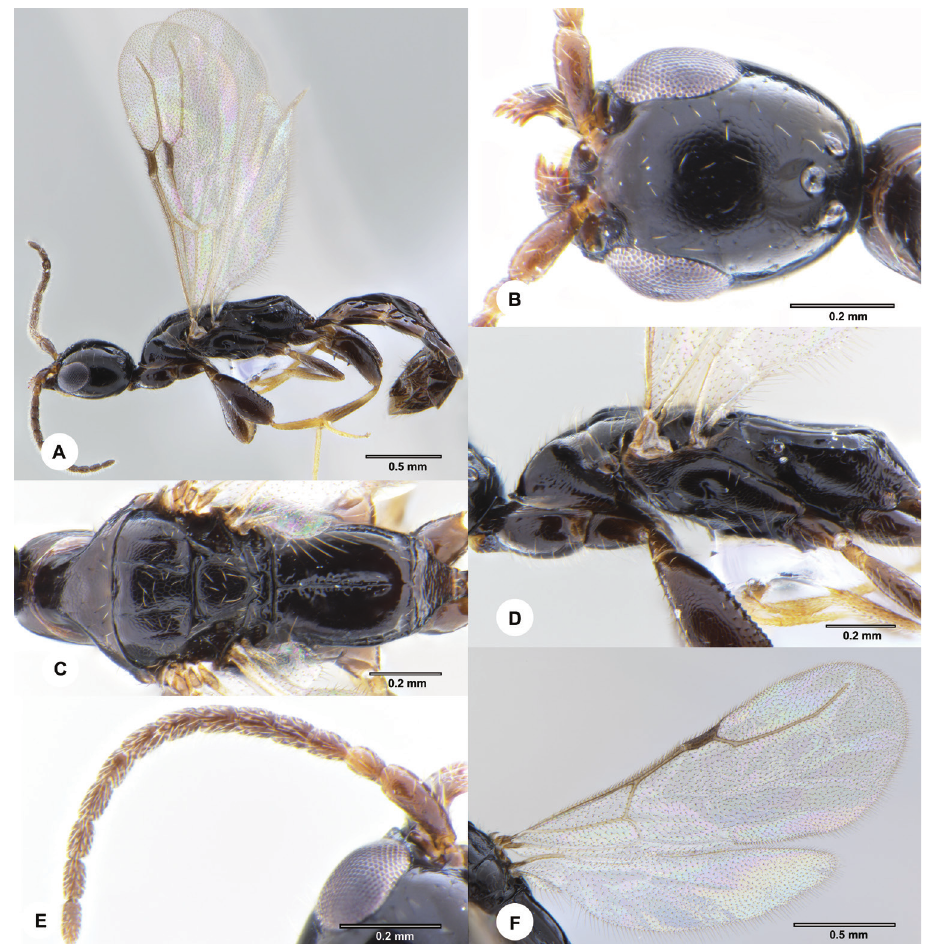
Figure 6. Foenobethylus yunkaishanensis Chen & Luo, sp. nov., male, holotype (SCAU 3048315) A lateral habitus B head, dorsal view C mesosoma, dorsal view D mesosoma, lateral view E antenna F